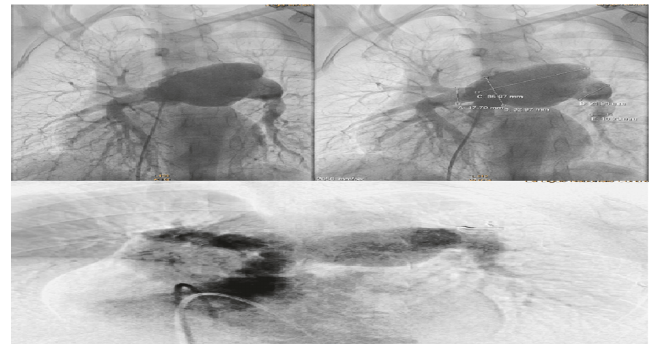
Figure 3: A pulmonary artery angiogram revealed a large aneurysm of the left pulmonary artery (47/65 mm) associated with a valvular stenosis.